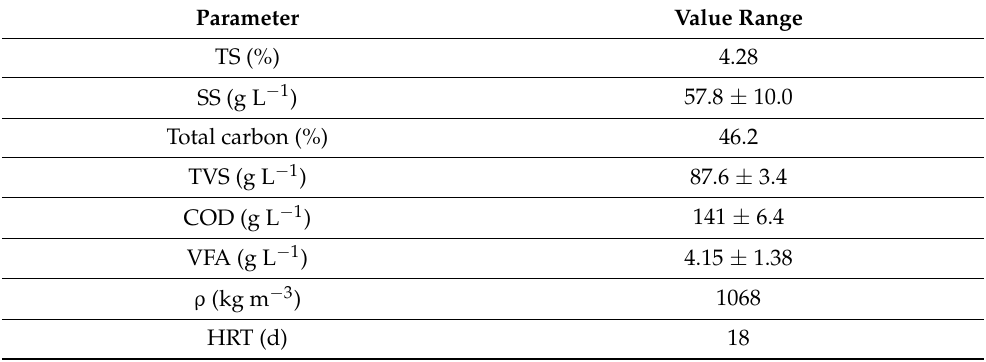
Table 1. Characteristics of the substrate used in the experiment.